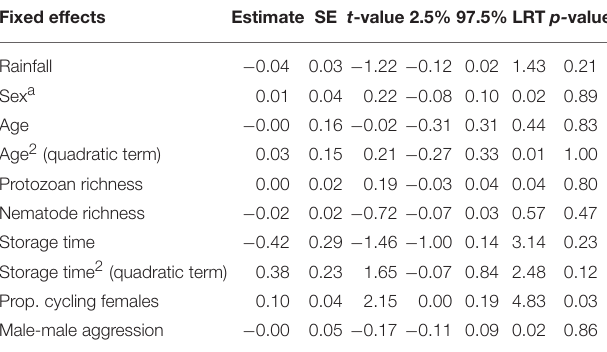
TABLE 1 | Estimates, standard errors (SE), and confidence intervals of fixed effects predicting variations in fecal neopterin concentrations across males and females of all ages ( N = 67 individuals and 372 samples; mean number of samples per individual ± SD: 5.6 ± 5.9; range: 1–31).